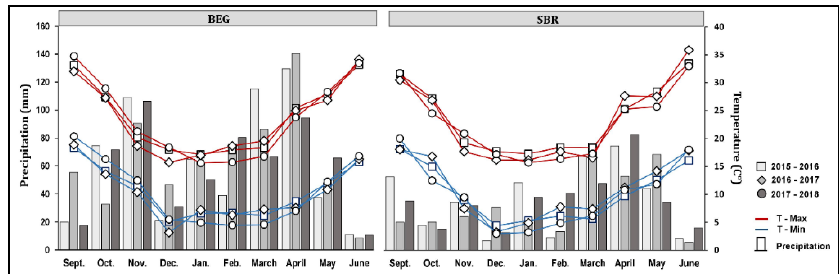
Figure 1. Average monthly precipitation, minimum and maximum temperature at both sites during the three experimental seasons (Data provided by the National institute of meteorology, Tunisia).